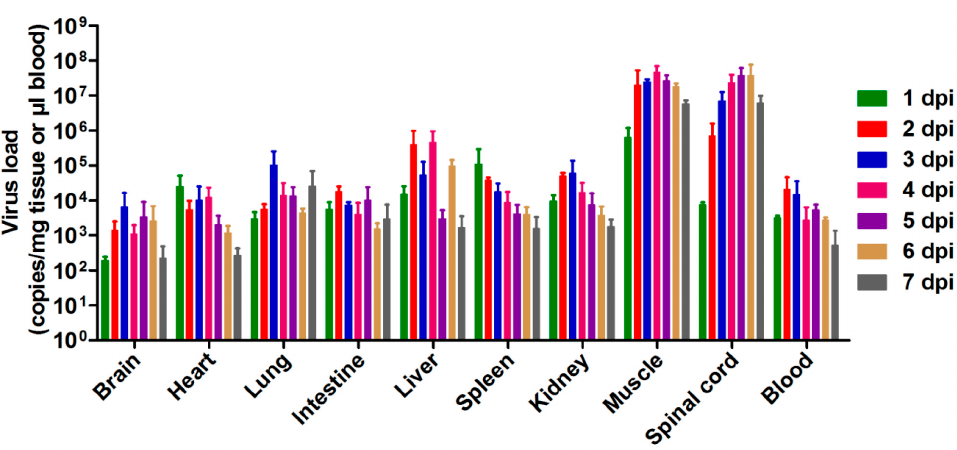
Figure 4. Viral loads within various tissues from EVD68-infected mice. One-day-old ICR mice were inoculated i.p. with 1.2 × 10 5 TCID 50 of US/MO/14-18947 per mouse. Tissues were collected every 24 hours after infection and viral loads within the indicated tissues were determined by real-time quantitative RT-PCR. Results are expressed as viral RNA copies per milligram of tissue or per microliter of blood. Data represent the mean ± SD for three mice per group.